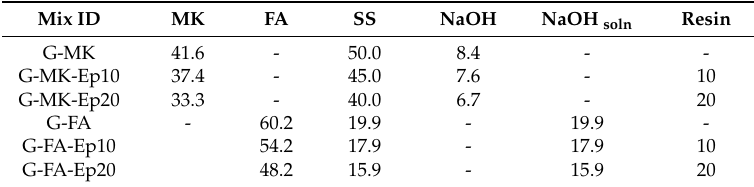
Table 2. Composition (wt %) of the samples used in this study. Mix ID MK FA SS NaOH NaOH soln Resin G-MK